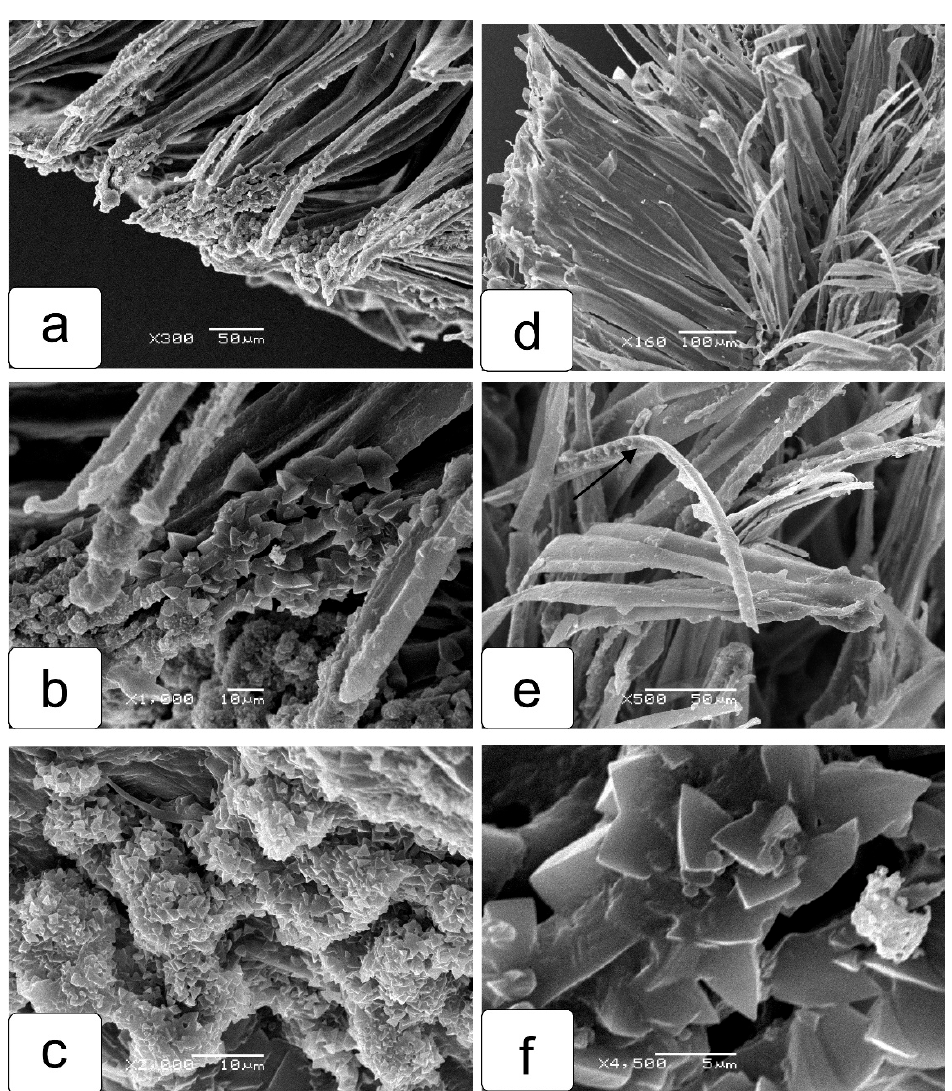
Figure 8. Calcium oxalate crystals in the cells of the outer layer of the seed coat. After opening the seed capsule, the cells begin to break into ribbons from the cell walls ( a , b , d , e ). A large number of calcium oxalate crystals ( a – c , f ) accumulate on the walls themselves and at their ends. However, when examining the surface of the seed removed from the seed capsule and washed (Figure 9a), no crystals are observed. The bursting cells of the seed coat first form rows of different configurations and density from the walls (Figure 9b,c), and then gradually separate from each other. Their ends are slightly twisted upon further